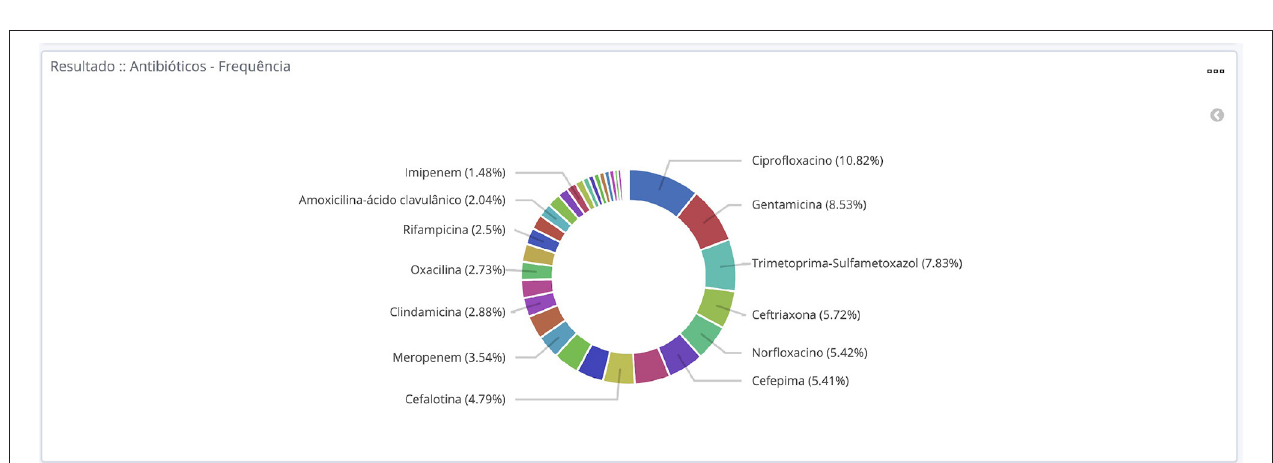
FIGURE 3 | Total frequency of microorganism isolated during the year 2018 at hospitals participating in the BR-GLASS Program.